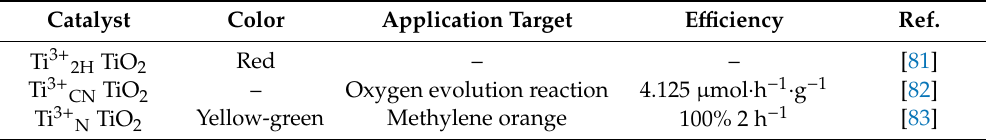
Table 4. Summary of stoichiometry modification of Ti 3 + self-doped TiO 2 photocatalysts. Catalyst Color